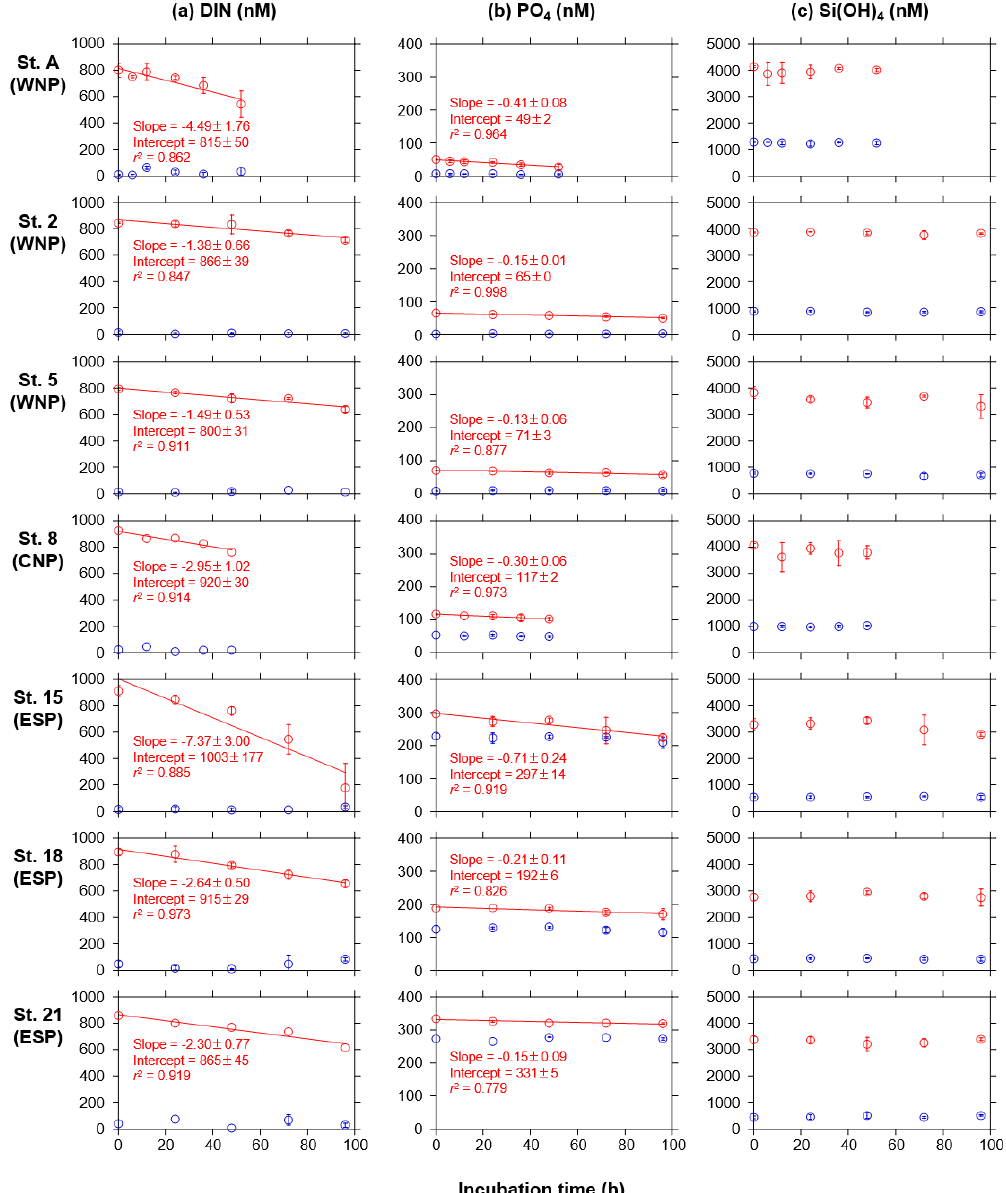
Figure 3. Temporal changes in concentrations of (a) DIN, (b) PO 4 , and (c) Si ( OH ) 4 in the control (blue) and treated (red) bottles during the incubation periods at seven stations. Error bars denote standard deviations ( n = 3). Duplicate or single data are denoted as mean or single values without error bars. Linear regression lines are depicted when significant decreases ( p < 0 . 05) in the mean concentrations against time were observed. Errors of slope and intercept represent 95% confidence